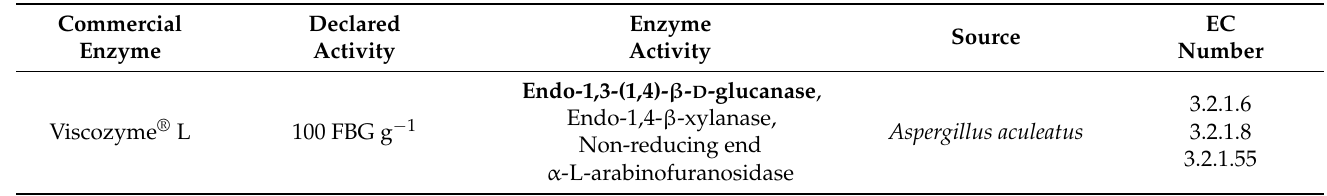
Table 2. Main and side activities of multi-enzyme cellulose-degrading preparation used in this